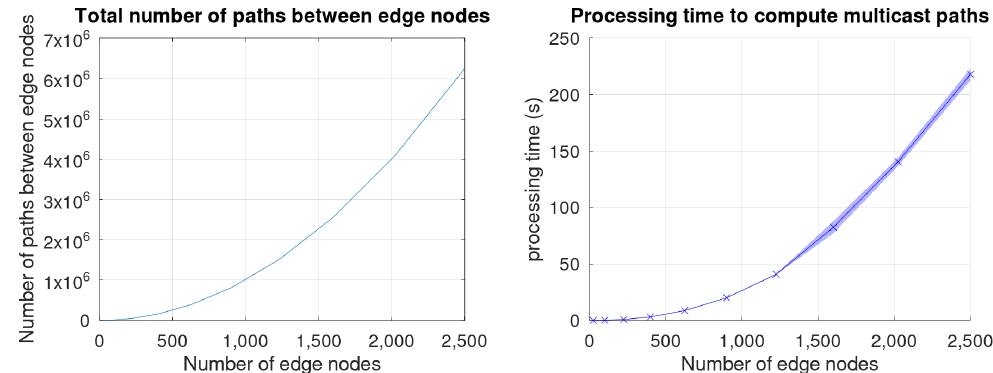
Figure 17. Total number of paths and Time to generate all possible multicast